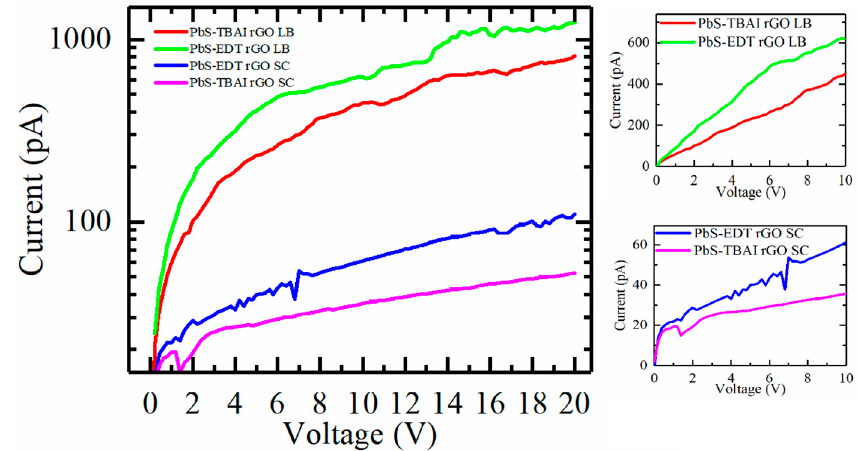
Figure 6. The I–V curves obtained for EDT and TBAI treated samples, prepared using LB and spin-coating techniques. Right panels show the linearity of the I–V curves.